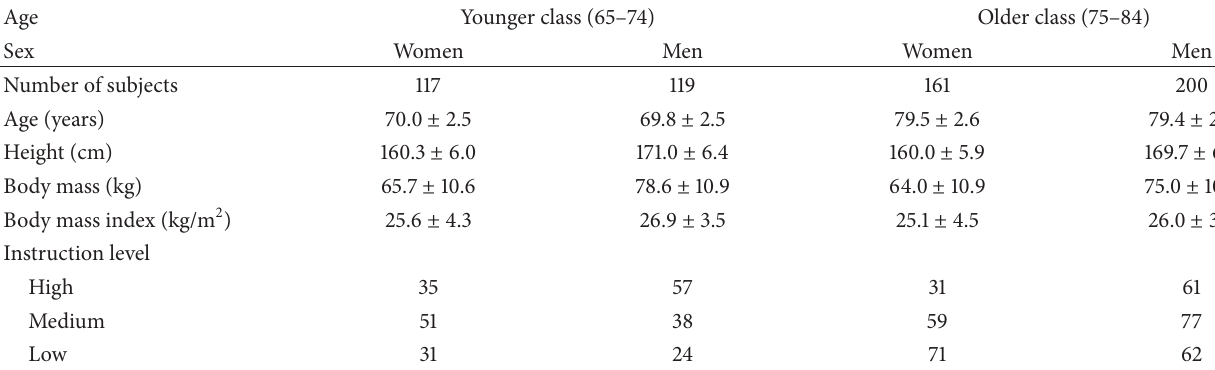
Table 1: Participant characteristics. Values are mean ± SD.